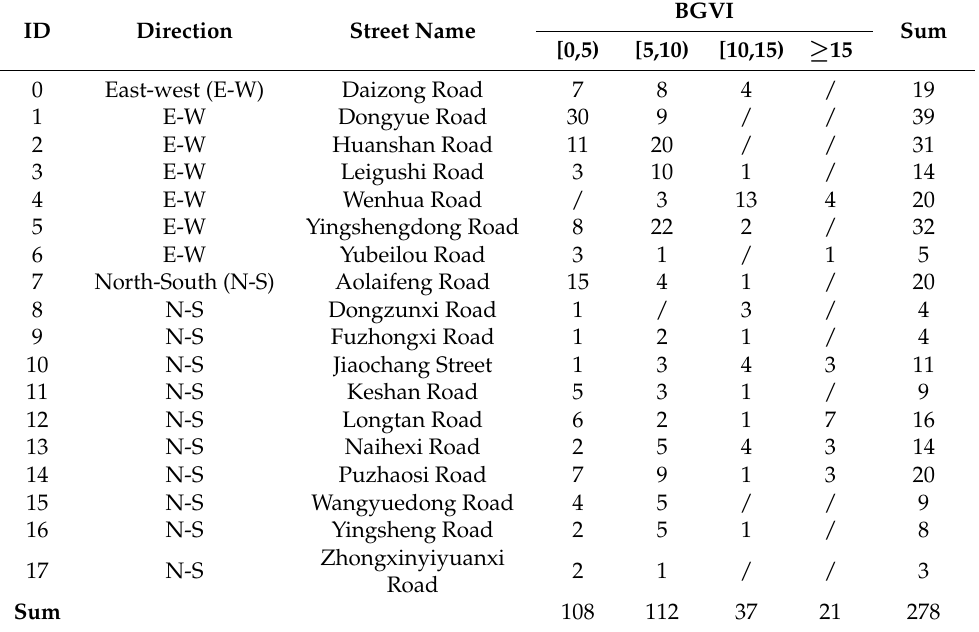
Table 1. BGVI summary of the 278 street sample